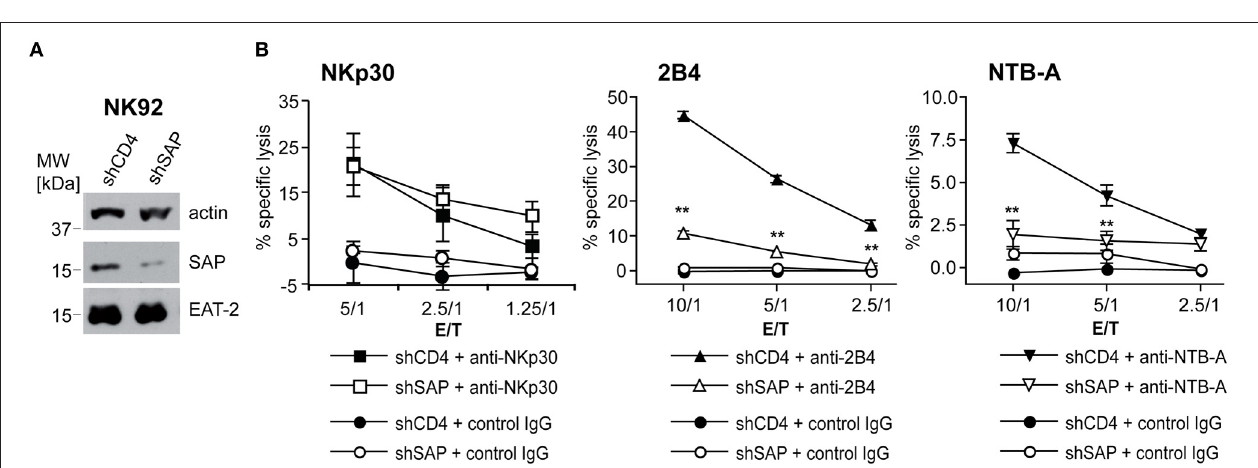
FIGURE 2 | SAP knockdown leads to diminished 2B4 or NTB-A-mediated cytotoxicity in cell lines. To study the impact of a SAP-knockdown on NK cell cytotoxicity, NK92-C1 cells stably expressing a small hairpin RNA against SAP (shSAP) or CD4 (shCD4) mRNA (as negative control) were analyzed. (A) Western blot analysis of SAP and EAT-2 expression in NK92-C1 shCD4 and shSAP cells. (B) NK92-C1 shCD4 and shSAP were used as effector